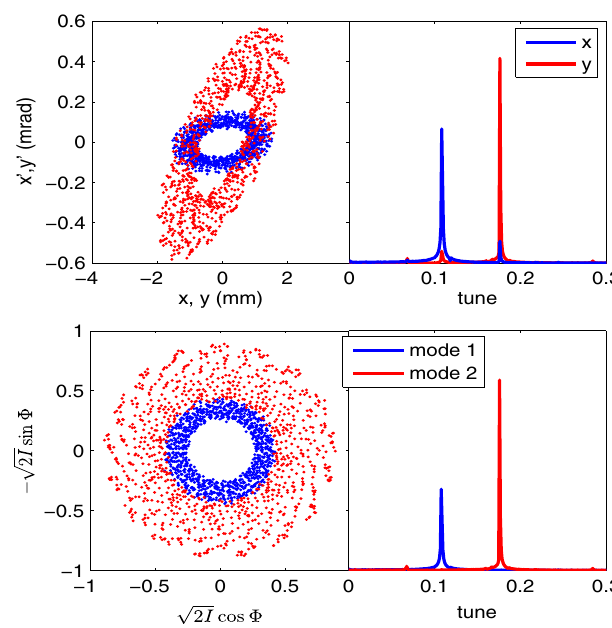
FIG. 3. The phase space plots for the raw data (top) and decoupled modes (bottom) at BPM [12 1].